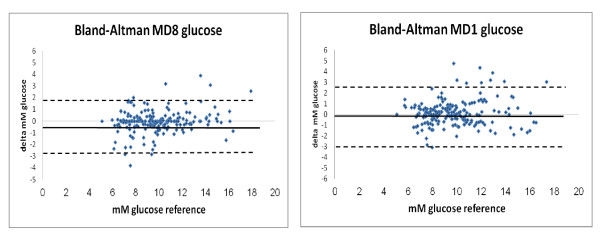
Bland-Altman plots. Mean reference plasma glucose vs. microdialysis glucose, eight-hour calibration (MD8; left) and single calibration (MD1; right). Bold line: lines of equality; dotted lines: limits of agreement (1.96*SD).